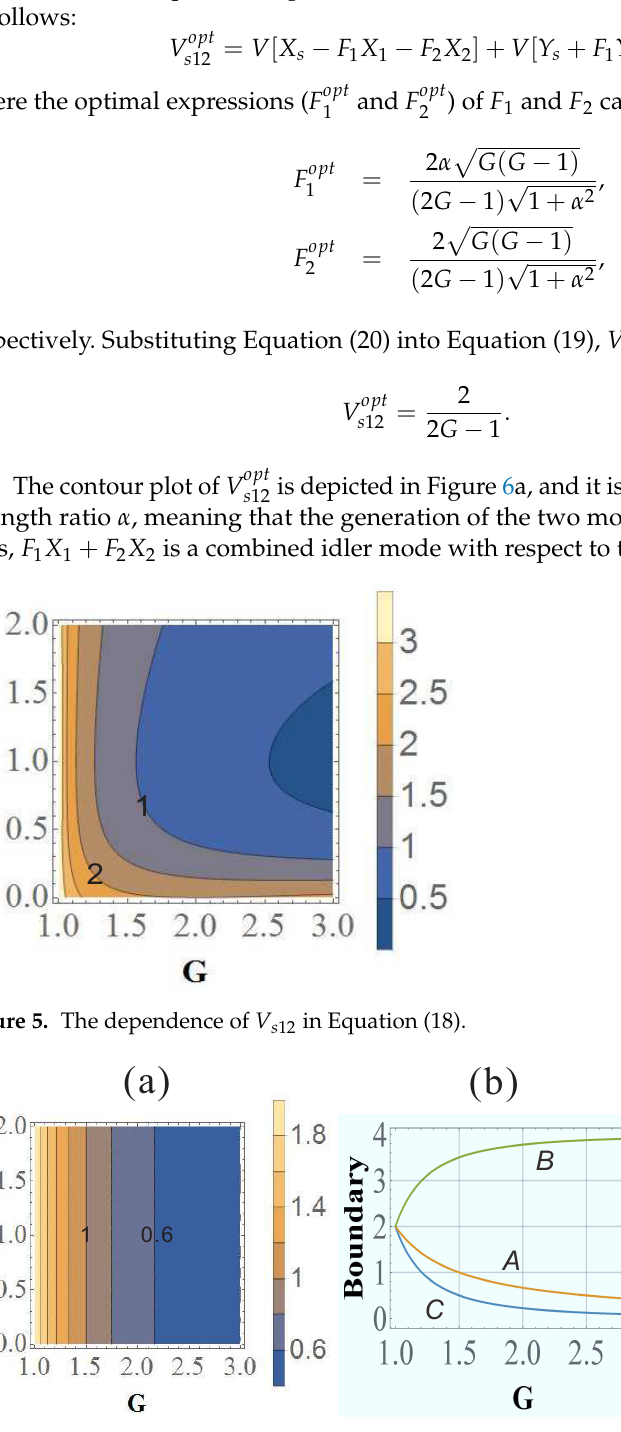
in Equation (21); ( b ) the dependence of V opt s 12